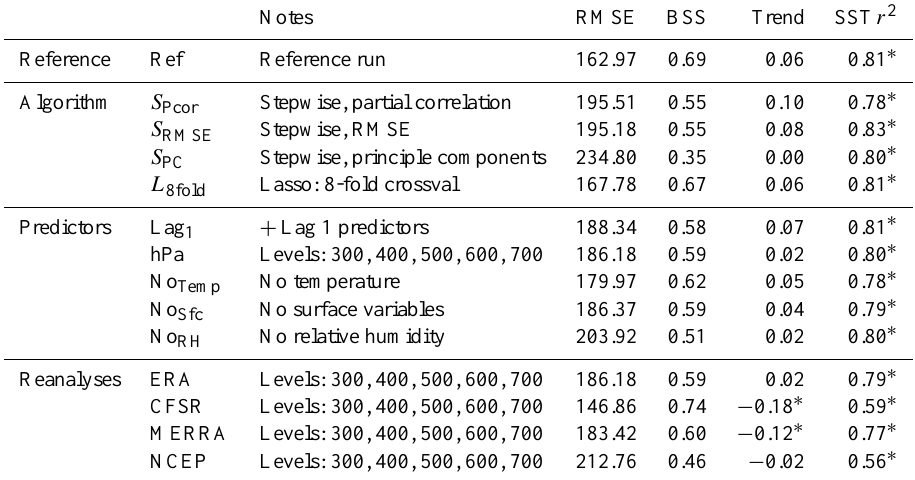
Table 3. Results of the sensitivity experiments for MB 4750 : skill scores RMSE (mmw.emonth − 1 ) and BSS, linear trend (mw.eyr − 1 ) and correlation with Pacific SST Anomalies (detrended, without taking RMSE into account). Trends and correlation values adjoined with a ∗ indicate significance at p < 0 .